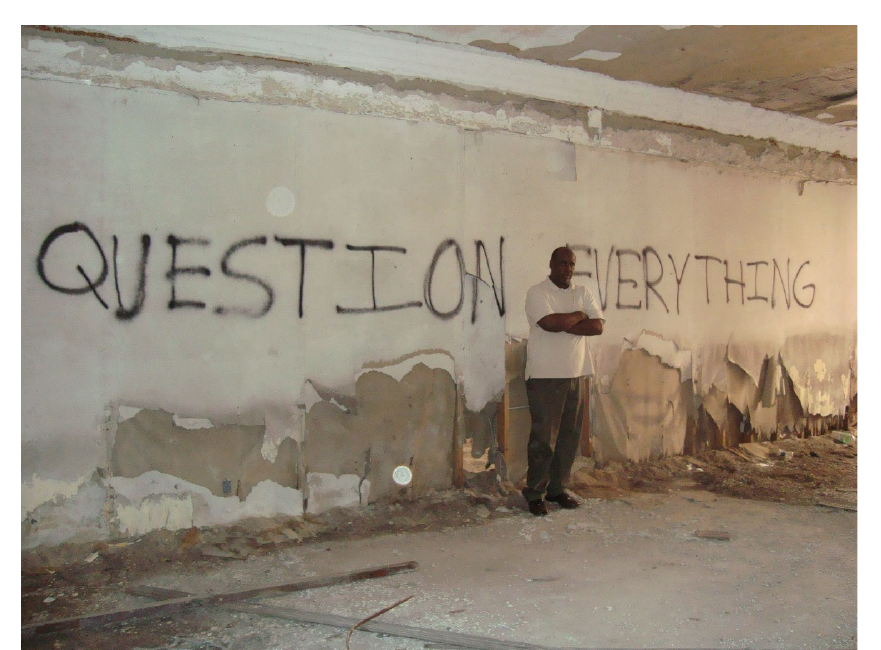
Figure 9. Olon Dotson in abandoned, vacant, vandalized Gary Methodist Church in Gary, Indiana (Photo courtesy of Ball State University Architecture Karen